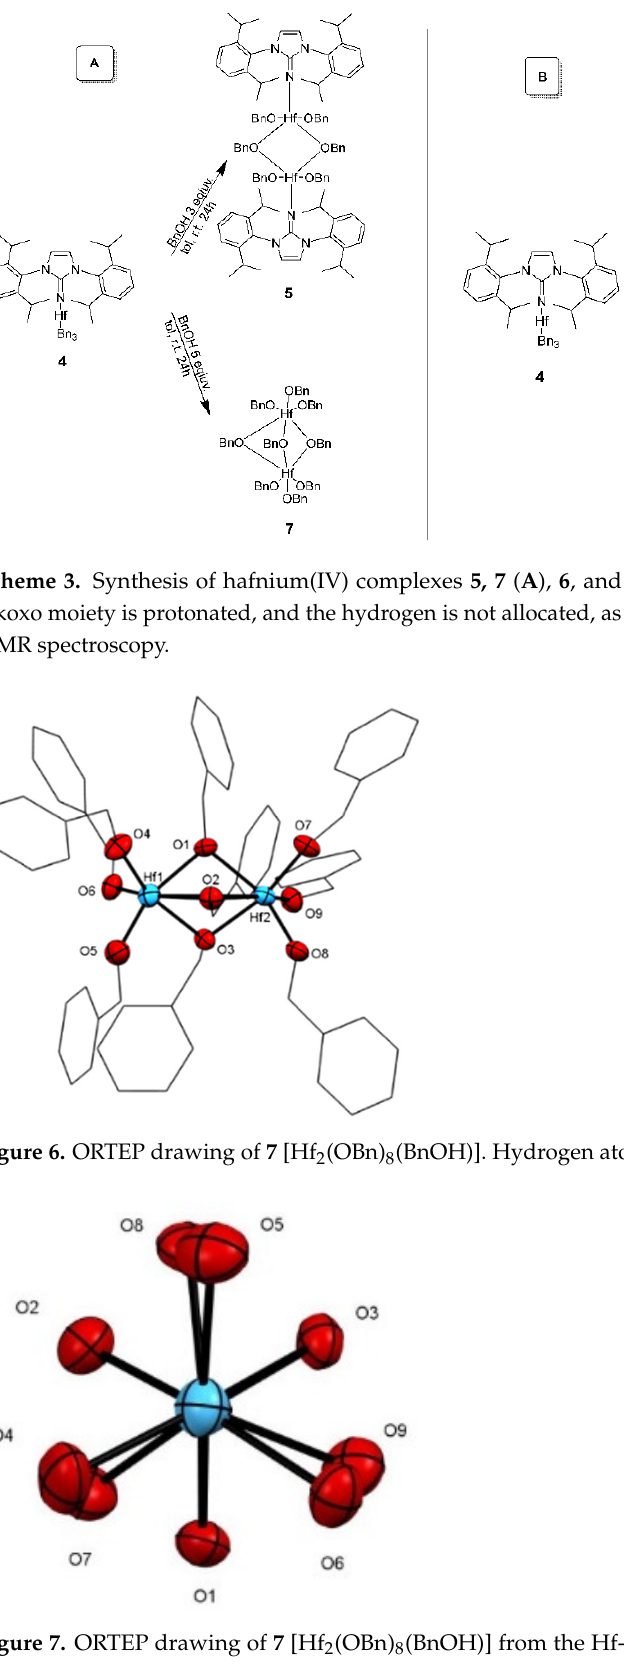
Figure 8. ORTEP drawing of 8 [Hf 2 (O i Pr) 8 ·( i PrOH) 2 ]. Isopropyl atoms are shown in wireframe mode to clarify the structure. Hydrogen atoms are omitted for clarity. In complex 5 , the hafnium atoms are bridged by only two alkoxy units, whereas in complex 7, the hafnium atoms are bridged by three alkoxy units. This coordination difference is the result of the bulkiness and the steric repulsion of the alkoxy moieties with the large imidazolin-2-iminato ligand. In the latter complex, due to the high oxophilicity of the metal center, an additional neutral molecule of alcohol is also coordinated. Furthermore, by using a similar procedure to prepare complex 7 but with less alcohol, i PrOH, the dimeric structure of complex 8 is obtained (Figure 8). In complex 8 , four isopropoxide units are connected directly to each hafnium, and only two isopropoxides